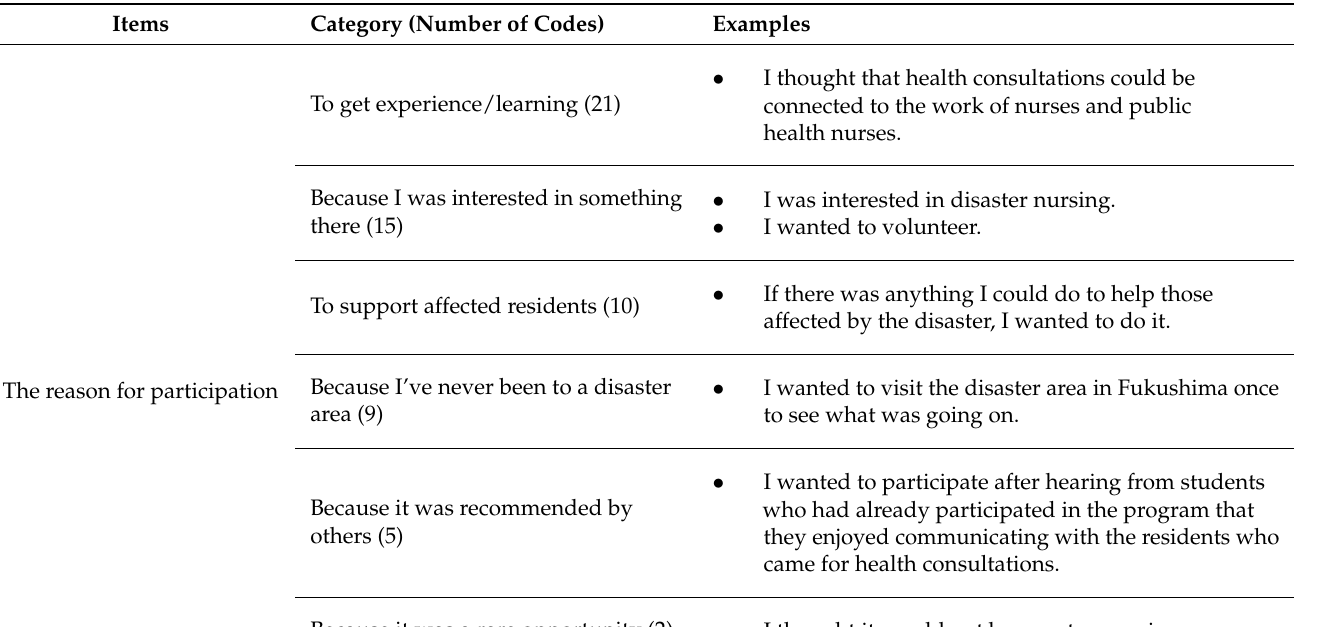
Table 3. Responses to the